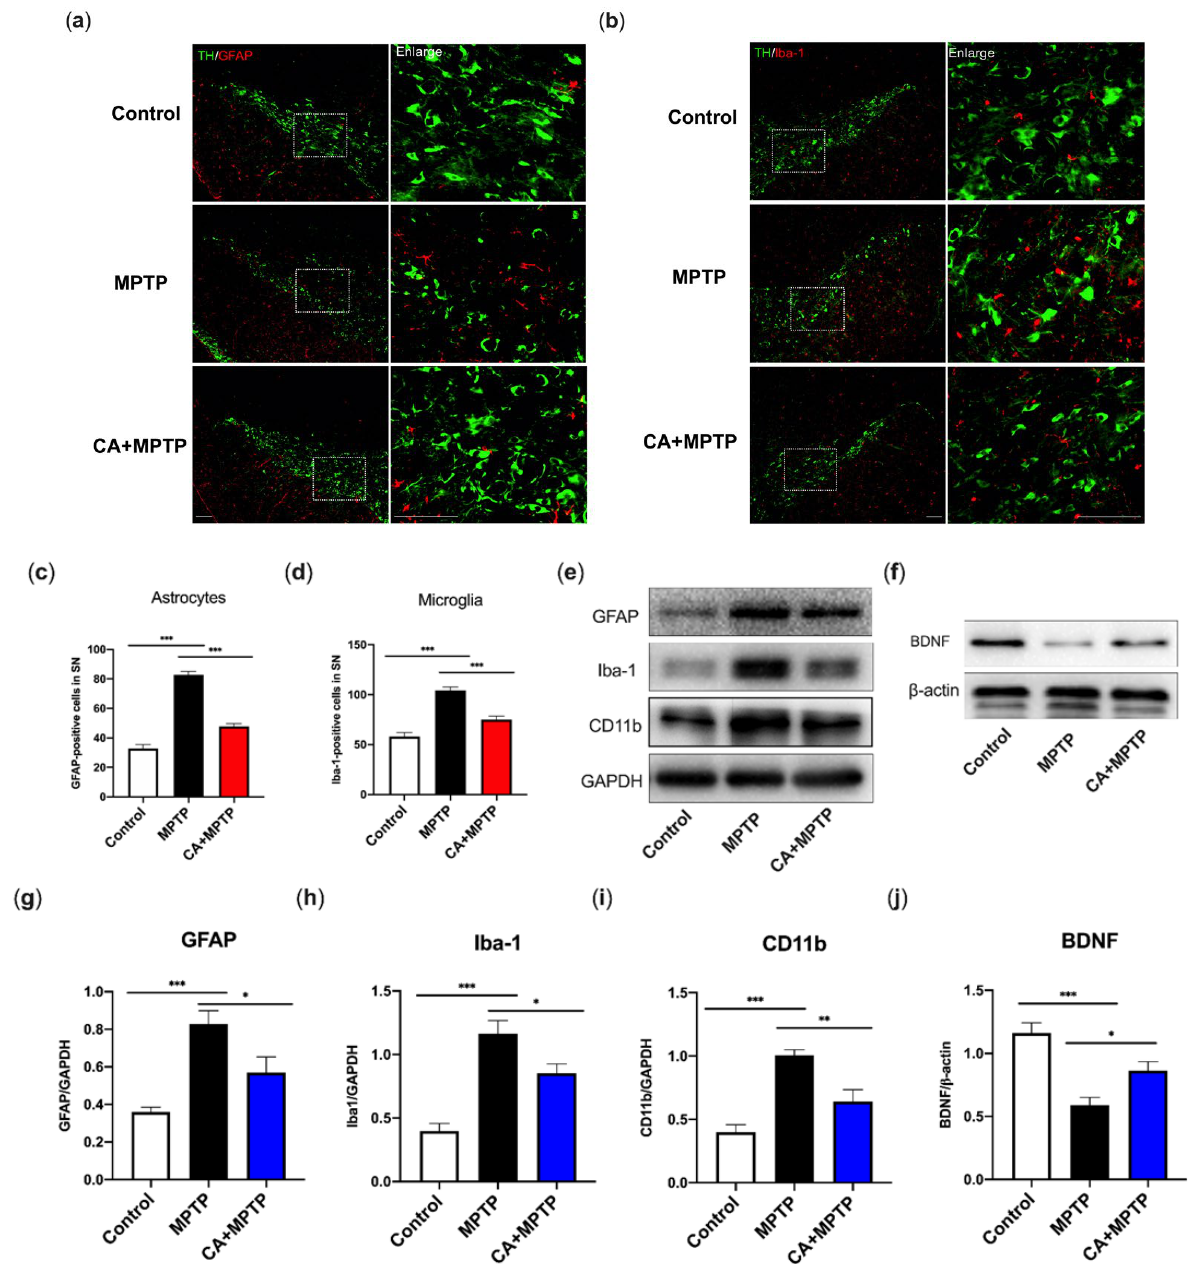
Figure 3. CA inhibited MPTP-induced microglial and astrocyte activation in SN and striatum, respectively, accompanied by the restoration of striatal BDNF. ( a ) Representative double-IF staining for TH (green) and GFAP (red) in SN. Scale bars: 100 µm. ( b ) Representative double-IF staining for TH (green) and Iba-1 (red) in SN. Scale bars: 100 µm. ( c ) Quantification for the number of GFAP-positive cells. ( d ) Quantification for the number of Iba-1-positive cells. ( e , f ) Representative bands of Western blotting for the expression of striatal GFAP, Iba-1, CD11b and BDNF. ( g – j ) Quantification for protein expression, band intensity normalized to GAPDH or β -actin. Statistical comparison by one-way ANOVA with Tukey’s post hoc test. Data represent means ± SEM. * p < 0.05, ** p < 0.01, *** p < 0.001. n = 4 for IF, n = 5 for Western